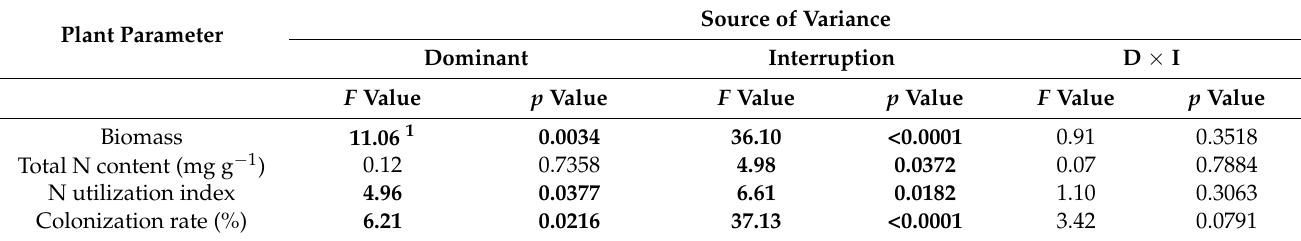
Table 3. Analysis of variance (ANOVA) effect of dominant (D) species of understory communities, interruption (I) by removing dominant species, and their interaction (D × I) on plant parameters of Ledum palustre vs. Vaccinium uliginosum in forests of northeast